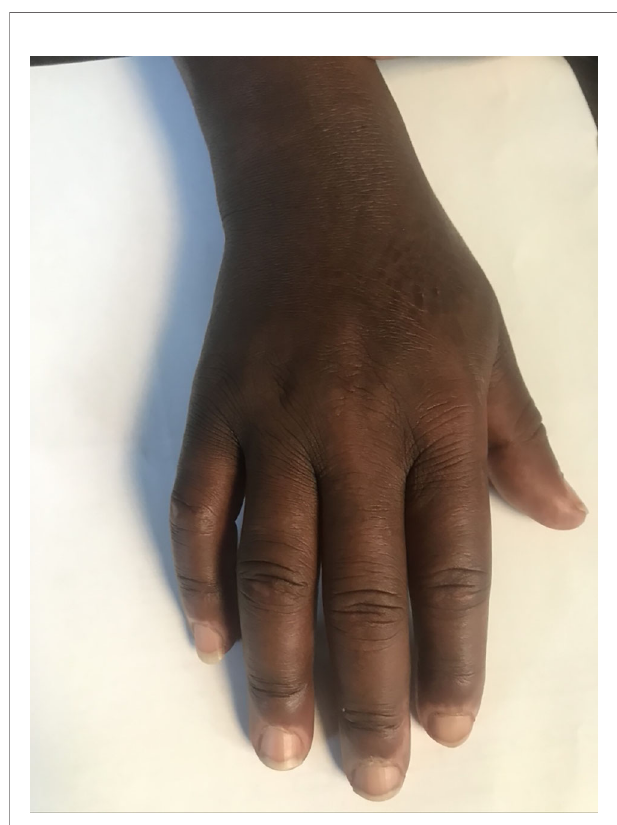
FIGURE 5 | Puffy fi ngers and cuticle hypo pigmentation in a child with detectable SSc speci fi c